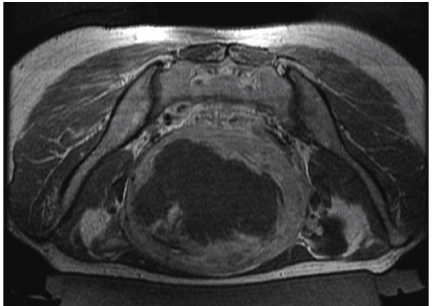
Figure 3: Contrast-enhanced axial T1-weighted MR image after treatment, showing nonperfused volume of